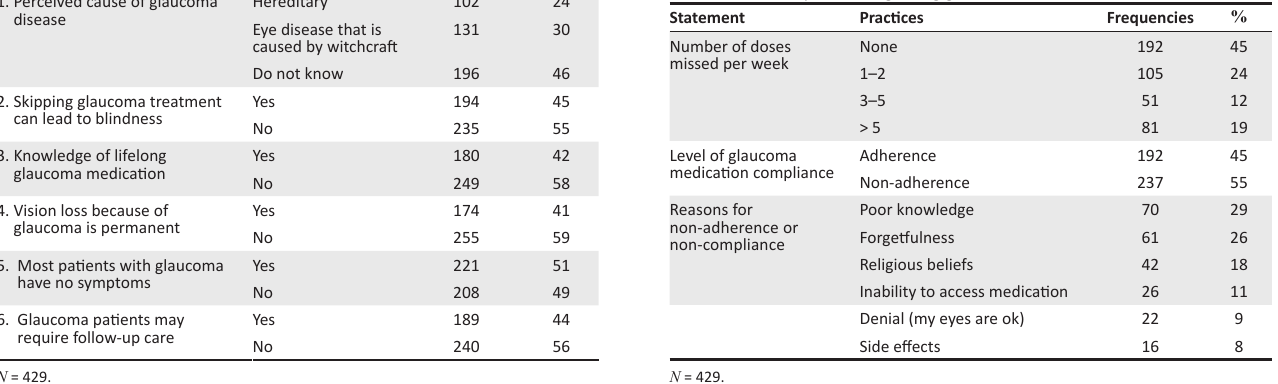
TABLE 2: Participants’ level of glaucoma knowledge. Variables